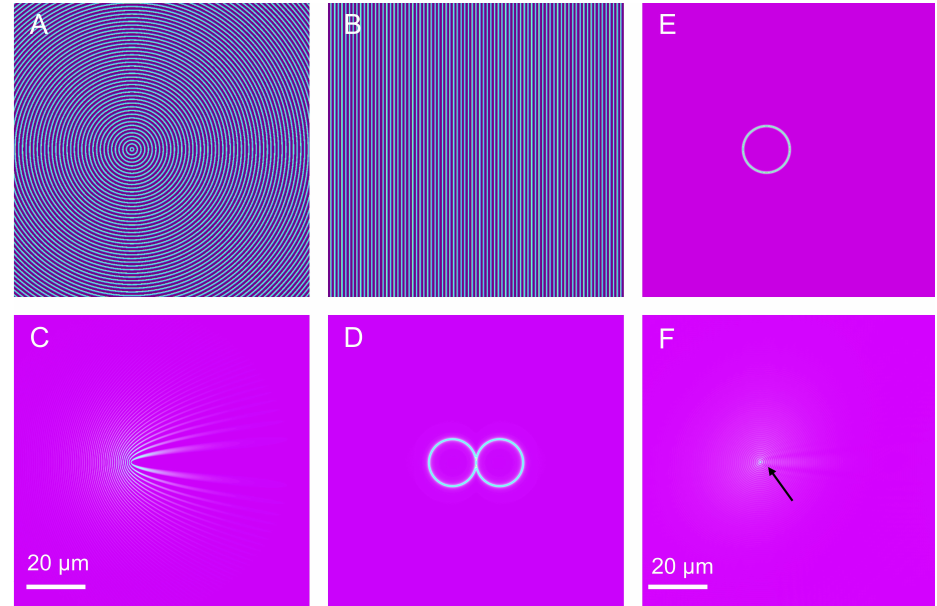
Figure 2. Simulation of SPRM imaging and reconstruction process for nanoparticle. ( A ) Scattered wave of nanoparticle; ( B ) SPW propagated at interface between gold film and medium; ( C ) SPRM image of nanoparticle and two-dimensional Fourier transform; ( D , E ) filter F 1 ; ( F ) reconstruction result for the nanoparticle. The black arrow points to the simulated nanoparticle deconvolution results.